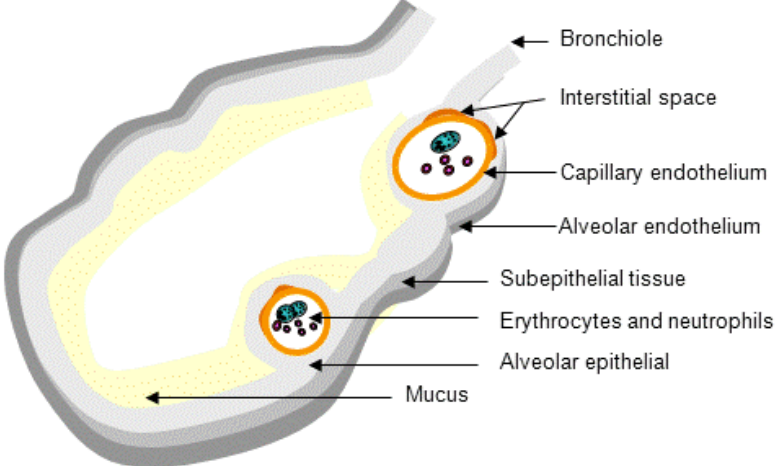
FIGURE 1. Schematic representation of a lung alveolus. GAGs are distributed in the interstitial space between the capillary endothelium and the alveolar epithelium, in the subepithelial tissue, and airway